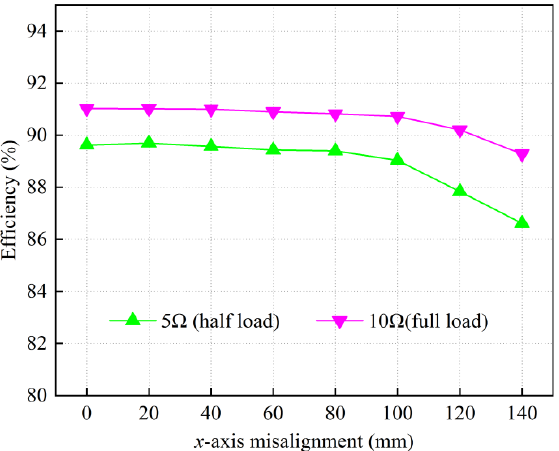
Figure 15. The efficiency under different load and misalignment conditions.